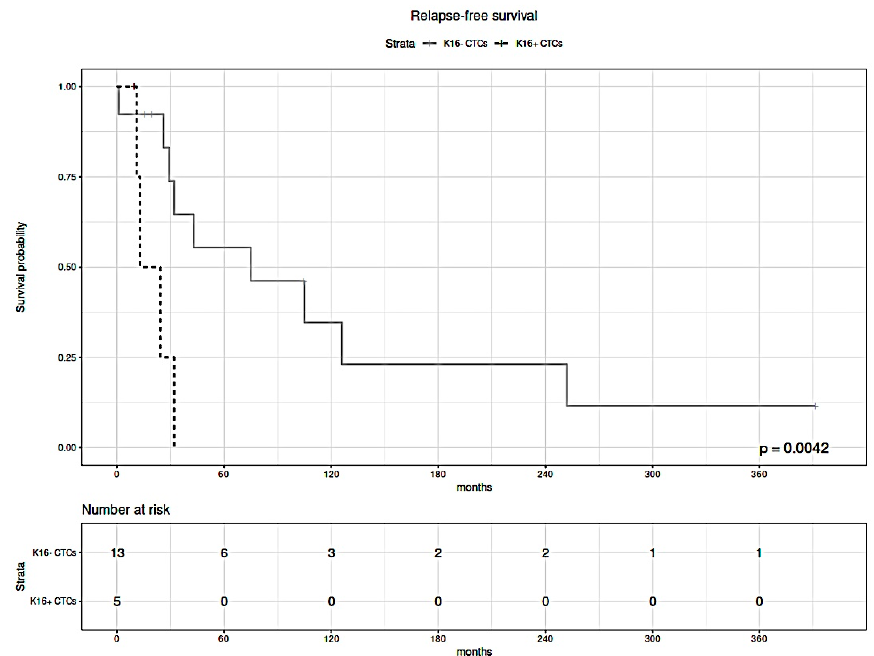
Figure 6. Kaplan–Meier estimates of the relapse-free survival of metastatic breast cancer patients with K16+ CTCs (black dashed line) and K16 − CTCs (solid gray line). Statistical significance was determined by a log-rank test. Shorter relapse-free survival correlates with the presence of K16+ CTCs in the blood ( p = 0.0042).